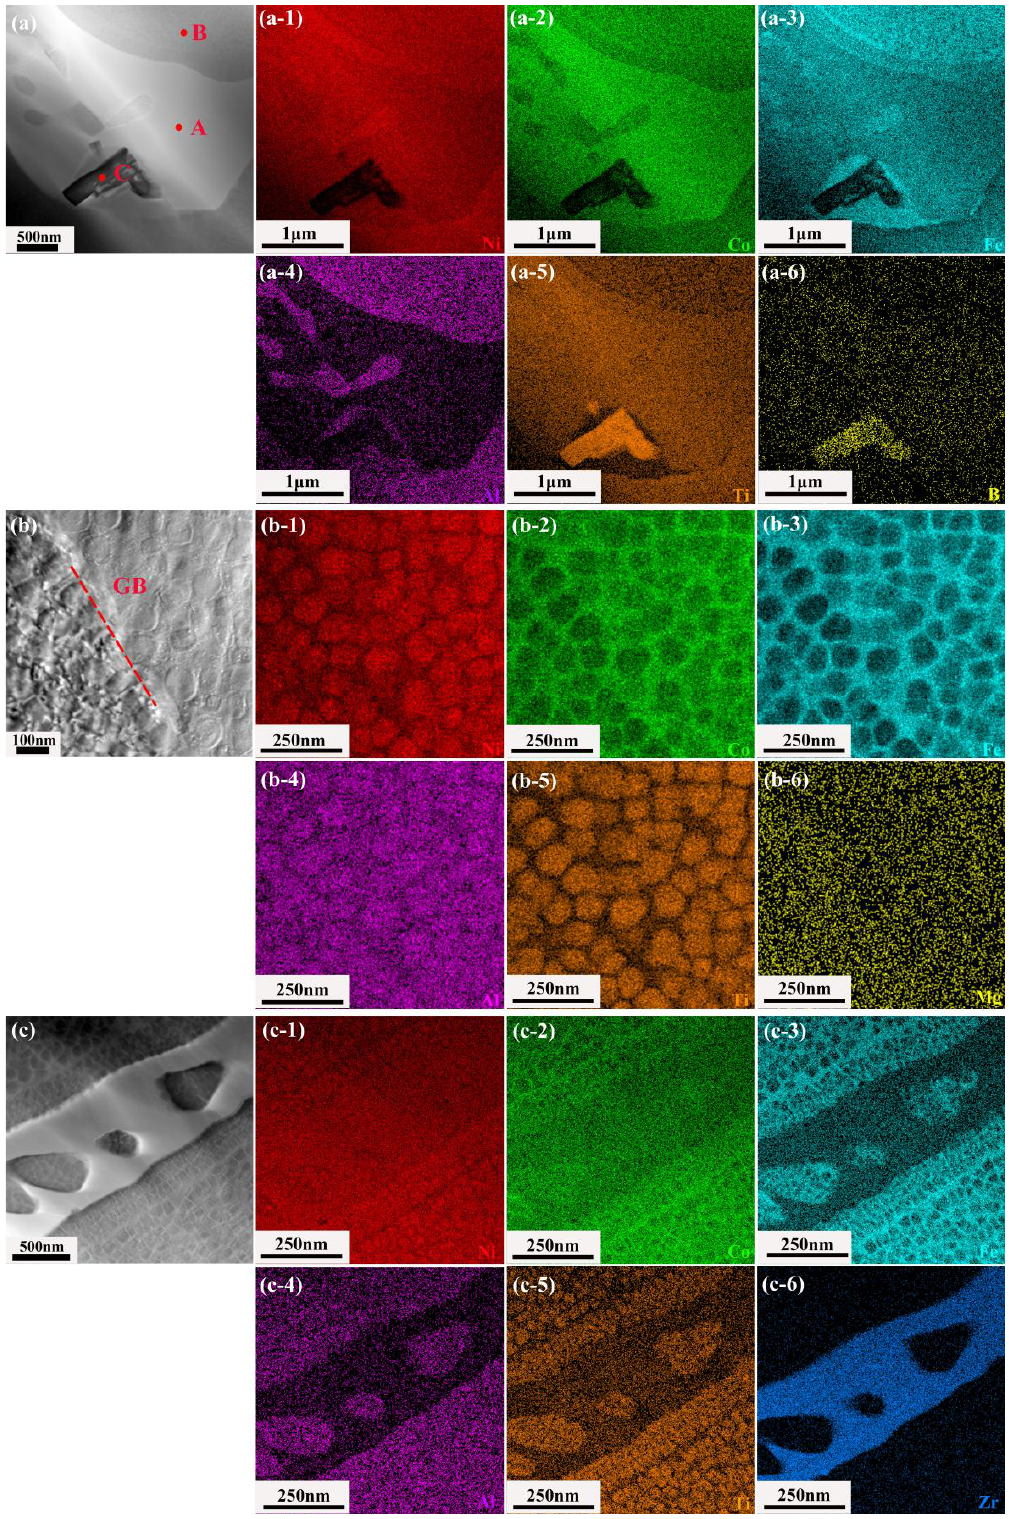
Figure 5. HAADF-STEM image and corresponding STEM-EDX elemental maps of the three as-cast HEAs. ( a ) B0.5 HEA, ( a-1 – a-6 ) EDS compositional distribution mapping of the Ni, Co, Fe, Al, Ti, and B elements; ( b ) Mg0.5 HEA, ( b-1 – b-6 ) EDS compositional distribution mapping of the Ni, Co, Fe, Al, Ti, and Mg elements; ( c ) Zr0.5 HEA, ( c-1 – c-6 ) EDS compositional distribution mapping of the Ni, Co, Fe, Al, Ti, and Zr